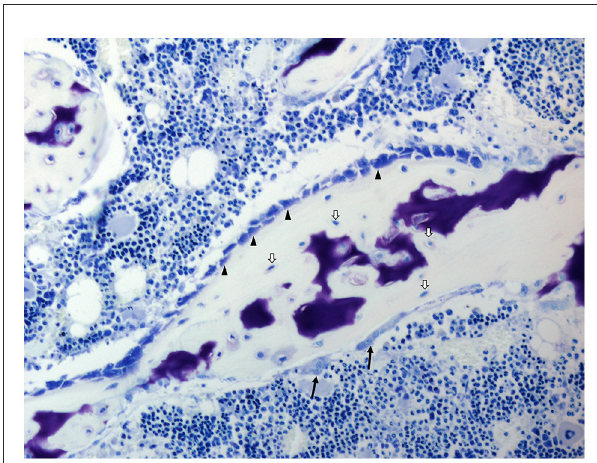
FIGURE3 Histology of the bone of a domestic pig; toluidine blue stain. Osteoblasts (arrowheads), osteocytes (white arrows), and osteoclasts (black arrows). Cell types are identified due to their morphological characteristics and position within specific bone compartments. Porcine bone marrow-derived stromal cells as well as osteoblasts and osteoclasts exhibit similar in vitro growth characteristics and osteoimmunological properties as their rodent and human counterparts (51,